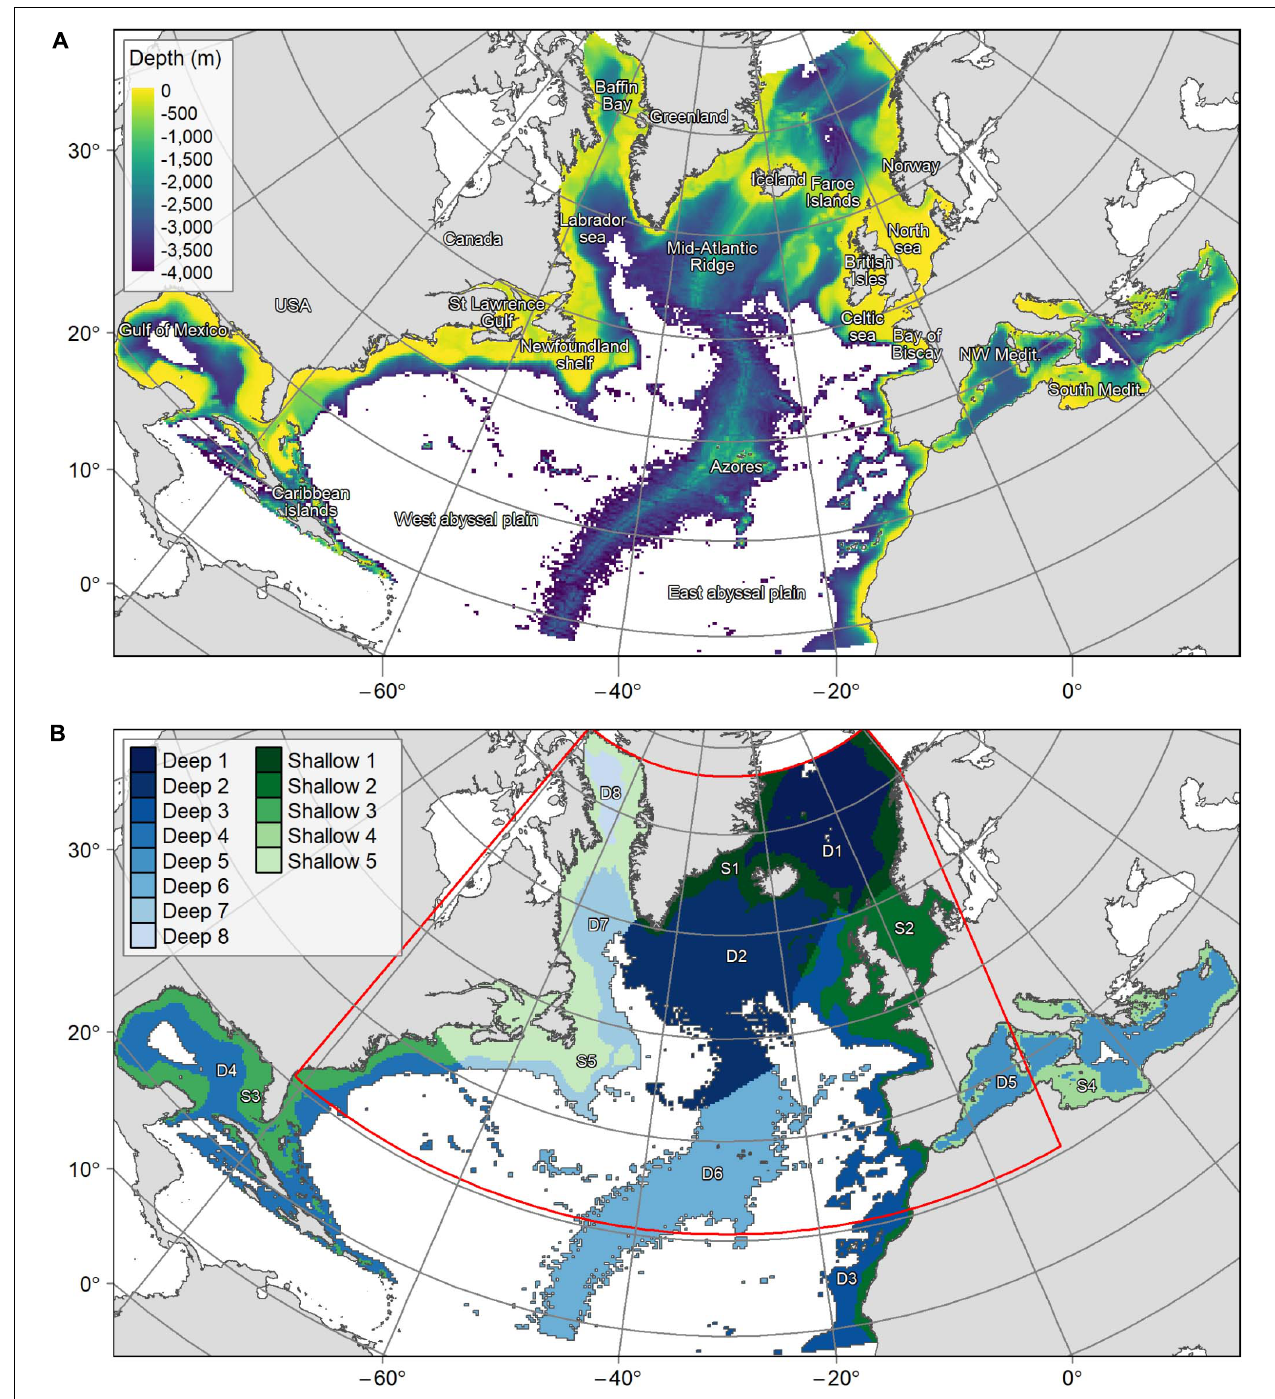
FIGURE 2 | (A) Bathymetry over the planning region. (B) Delimitation of the planning region into 13 “provinces.” “Deep” regions represent areas with an average depth below 800 m whereas “shallow” regions have an average depth between 0 and 800 m. The red line shows the limits of the smaller planning area used for connectivity